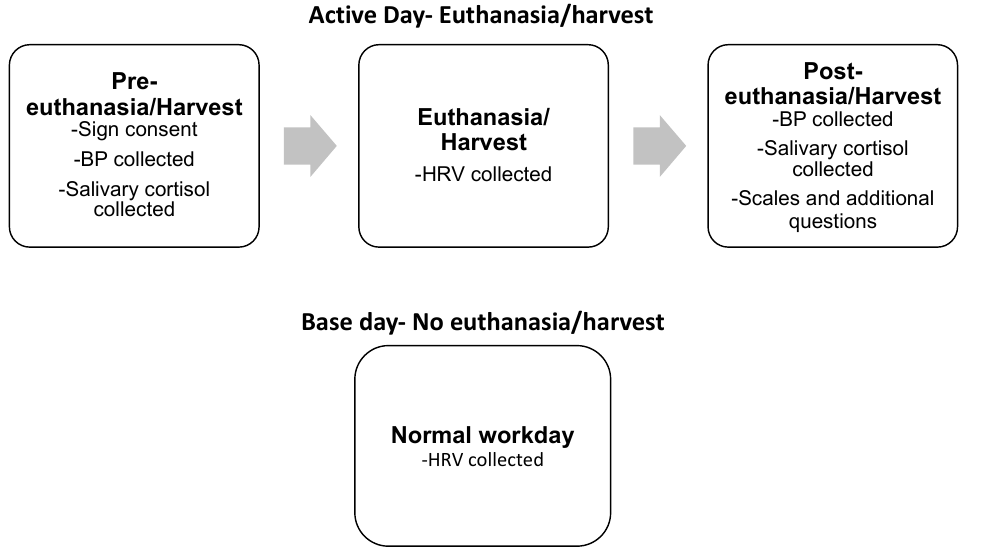
Figure 1. Shows a visual representation of methods for Experiment 1. BP: blood pressure; Figure 1. shows a visual representation of methods for Experiment 1. BP: blood pressure; HRV: heart HRV: heart rate rate variability.